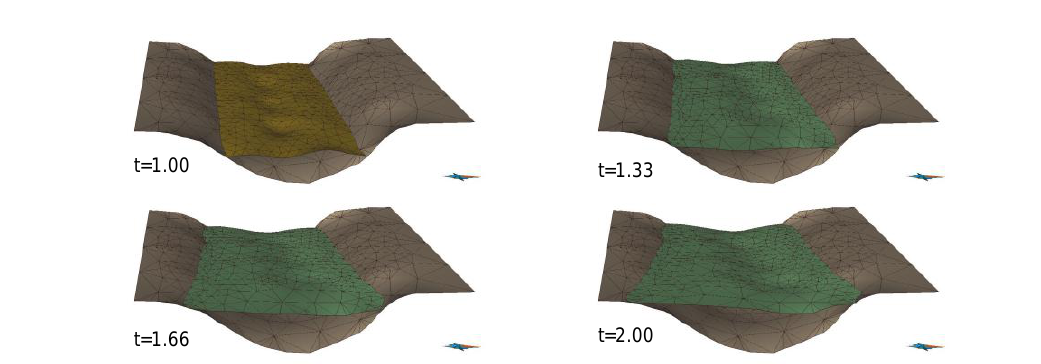
Figure 14. Top surface B in time interval [1,